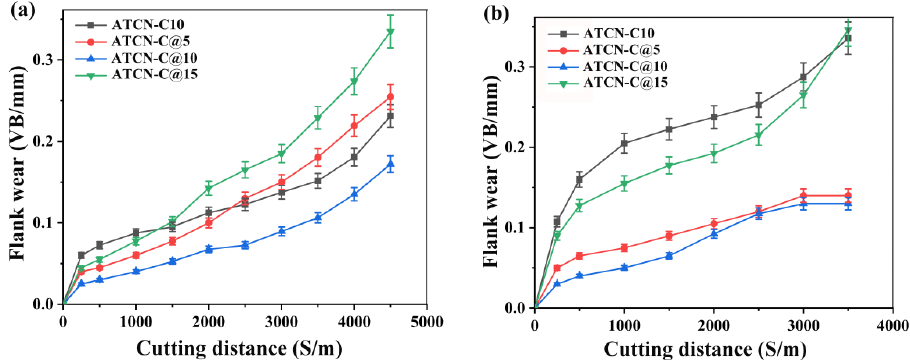
Figure 6. The flank wear of four ceramic tools at cutting speeds of ( a ) 100 m/min and ( b ) 300 m/min (test conditions: depth of cut α p = 0.2 mm, feed rates 𝑓 = 0.102 mm/r).